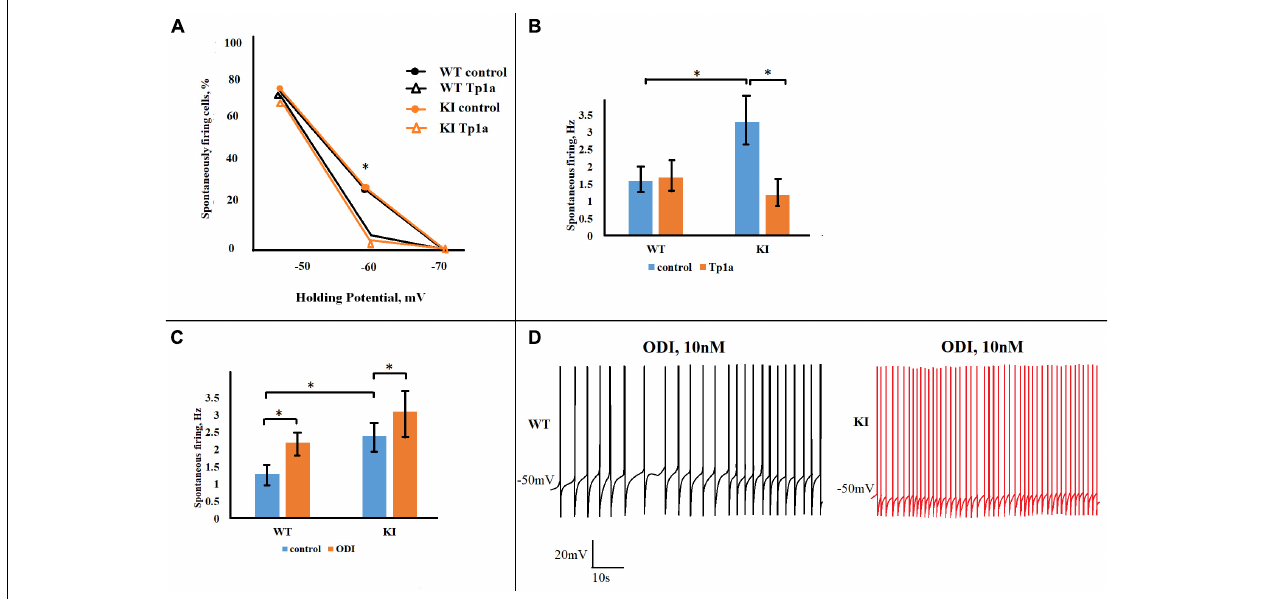
FIGURE 8 | Opposite effects of Tp1a and OD1 on spontaneous firing in TG neurons. (A) Diagram shows percentage of firing WT and R192Q KI TG neurons at different holding potentials in control and after Tp1a (7 nM, 30 min). *Indicates statistically significant change (Fisher test for proportions, p -values are given in the text body). Number of analyzed neurons at –70, –60, and –50 mV, respectively, are: n (WT, control) = 40, 40, 40; n (WT, Tp1a) = 32, 32, 31; n (KI, control) = 42, 42, 37; n (KI, Tp1a) = 33, 33, 33. (B) Bar charts represent average firing frequencies of WT and KI neurons in control and after Tp1a (7 nM, 30 min). *Indicates statistically significant change (paired Student’s t -test, p -values are given in the text body). Number of cells in each group: n = 31 (WT, control), n = 30 (WT, Tp1a), n = 23 (KI, control), n = 23 (KI, Tp1a). KI neurons fire with significantly higher frequency, which is reduced to the WT level after Tp1a application. (C) Application of 10 nM OD1 (paired data, recordings from the same cell) increases firing frequency of both WT and KI neurons at –50 mV. *Indicates statistically significant change (paired Student’s t -test, p -values are given in the text). Number of cells in each group: n = 17 (WT), n = 10 (KI), data are paired. (D) Examples of WT and KI neurons, firing at –50 mV before and after application of 10 nM